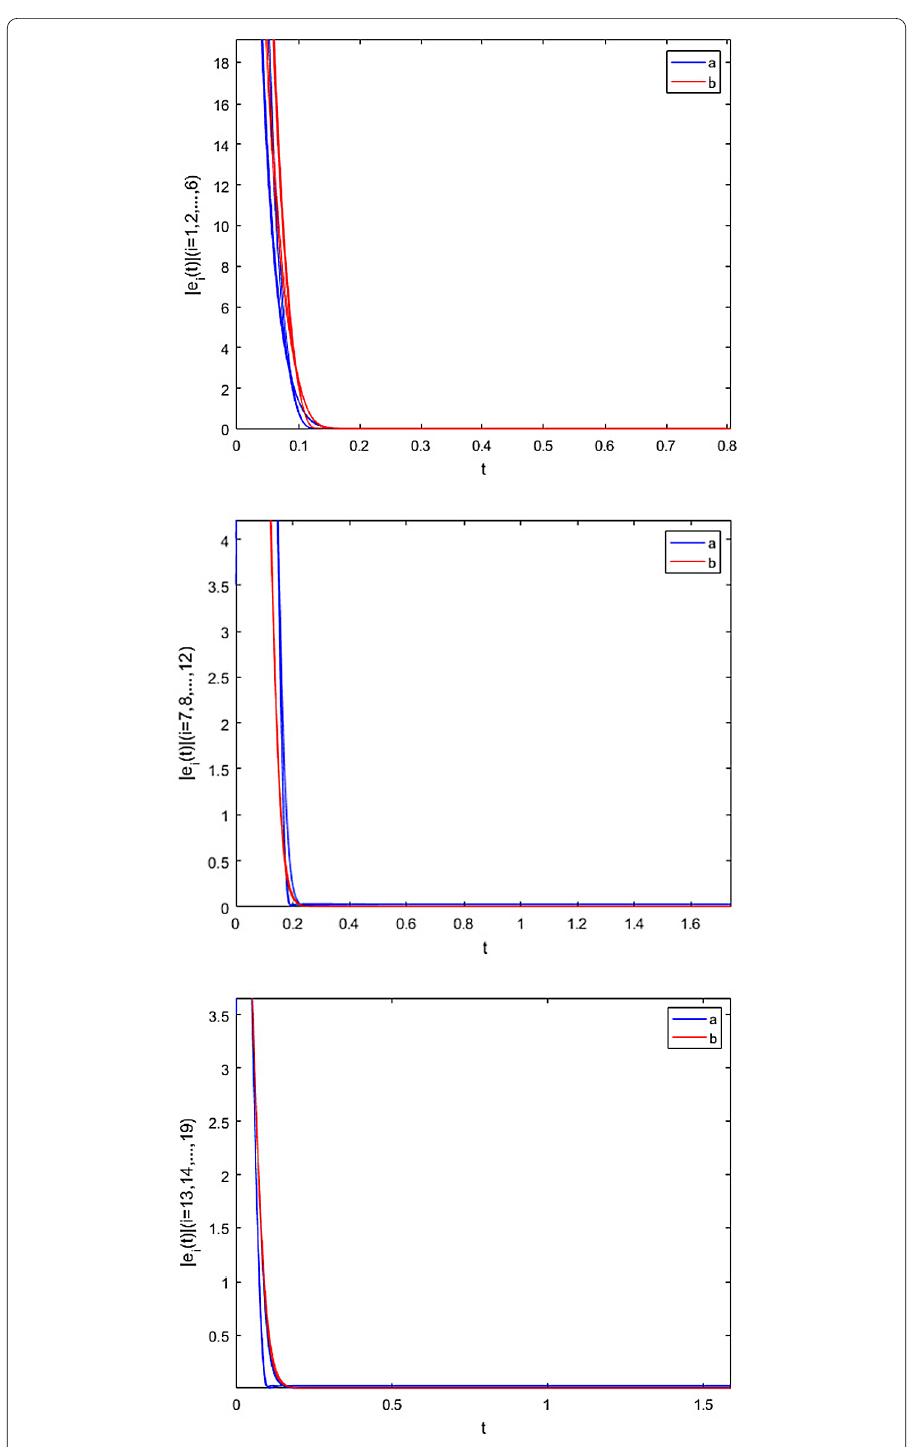
Figure 8 The synchronization errors under different